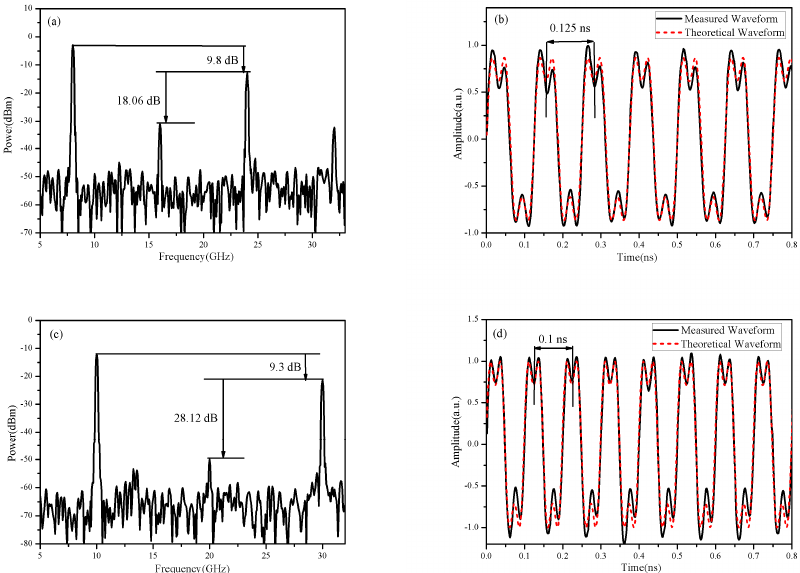
Figure 5. Electrical power spectrum and waveforms of the generated square waveform with repetition rates of 8 GHz ( a ) and ( b ), 10 GHz ( c ) and ( d ).